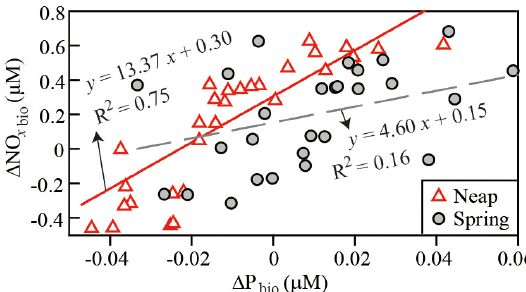
Figure 10. Relationship between biologically contributed NO x and phosphate during the spring tide and neap tide at station CT in the Luhuitou fringing reef in 6–13 February 2012.